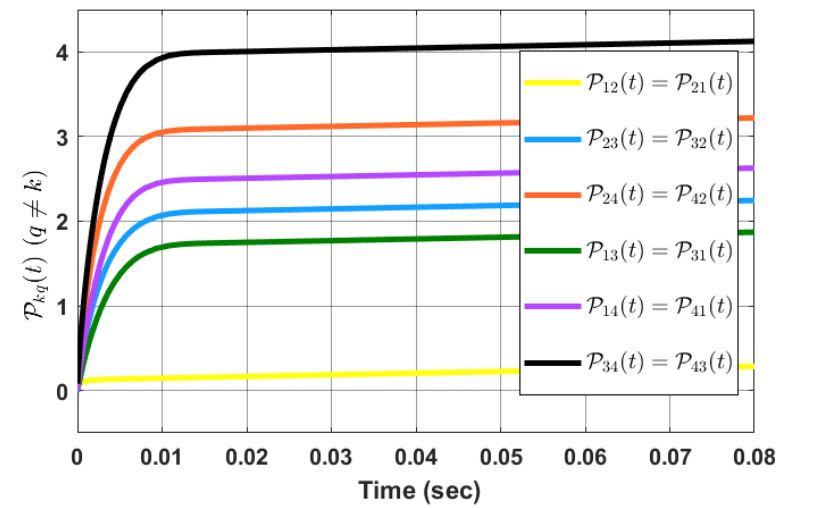
Figure 3. Evolution of P kq ( t ) with time.